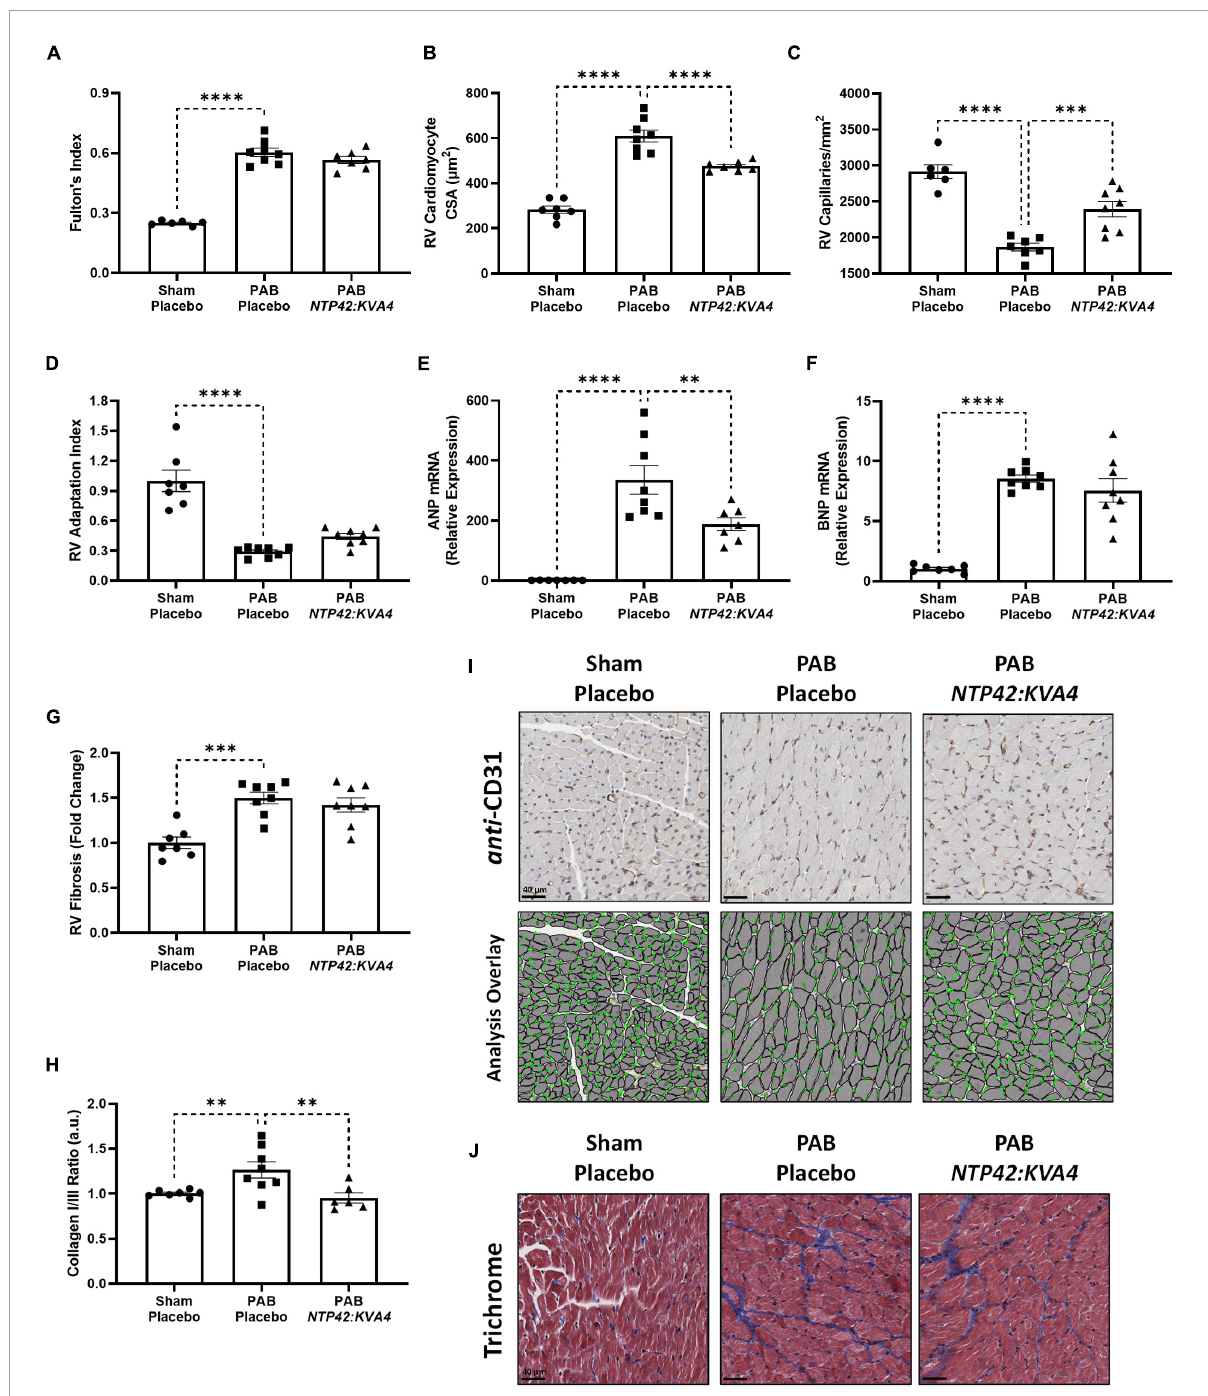
FIGURE4 Effect of NTP42:KVA4 treatment on RV hypertrophy and pathology in the PAB model. (A–H) show: (A) Fulton’s Index in the “Sham—Placebo,” “PAB—Placebo,” and NTP42:KVA4 groups [ n = 6, 8, and 7, respectively]; (B) RV cardiomyocyte size [ n = 7, 8, 7]; (C) RV vascularization [ n = 6, 7, 8]; (D) RV adaptation index [ n = 7, 8, 8], (E) RV ANP mRNA expression [ n = 7, 8, 7], (F) RV BNP mRNA expression [ n = 7, 8, 8], (G) RV fibrosis [ n = 7, 8, 8], and (H) RV collagen type I/III ratio, calculated from the RV collagen type I and III mRNA expression for each animal, and expressing the ratio in arbitrary units (a.u.) [ n = 7, 8, 6]. Data presented are the mean ± SEM. ** P < 0.01, *** P < 0.001, **** P < 0.0001 vs. “PAB—Placebo,” according to one-way ANOVA with Holm-Šídák correction. (I,J) show representative photomicrographs, selected from a random animal from each treatment group, of: (I) (Upper panel): Anti -CD31-stained RV tissue captured at 400 × magnification (scale bars represent 40 µ m), (Lower panel): Image analysis overlay showing annotated cardiomyocyte cross-sectional area (gray outline) and CD31 + vessels (green dots), and (J) Masson’s trichrome-stained RV tissue captured at 400 × magnification (scale bars, 40 µ